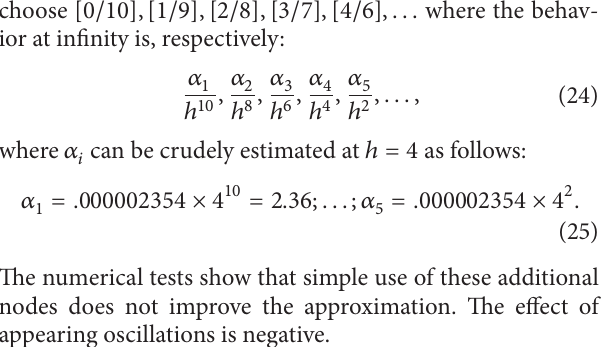
Figure 2: Graph of the error of Greenwood (7) approximation: (ℎ) − 𝐹 (𝐺) (ℎ) . 𝐹 5/2 5/2